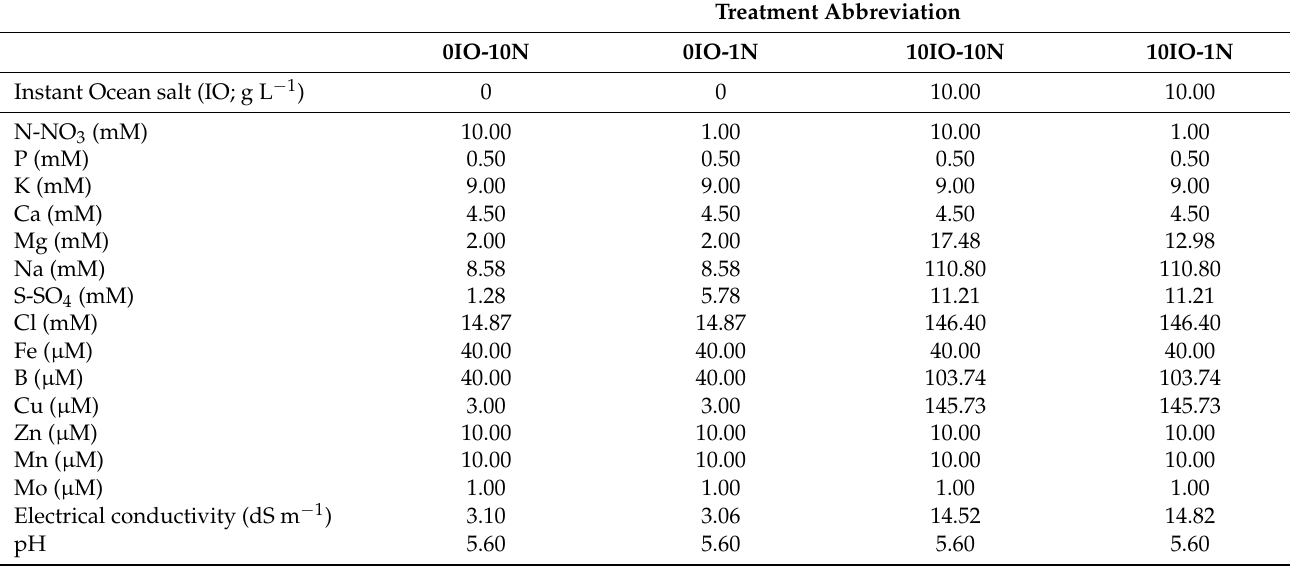
Table 2. Mineral composition, electrical conductivity (EC), and pH of the four nutrient solutions used in the experiment with Swiss chard and sea beet grown hydroponically under